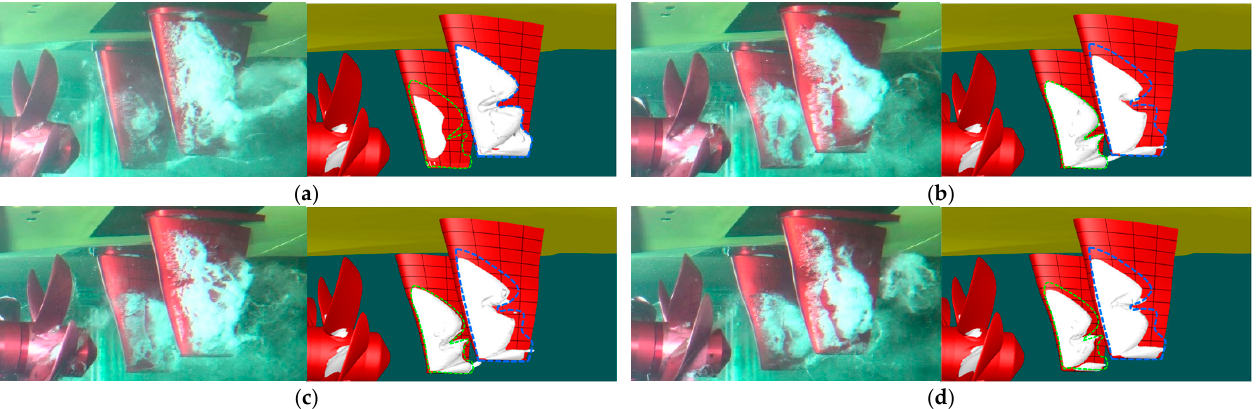
Figure 18. Experimental observation and numerical prediction of surface cavitation on the twin twisted rudders at δ R = − 16°: ( a ) flat rudder; ( b ) TR-ini; ( c ) TR-int; ( d ) TR-fin.